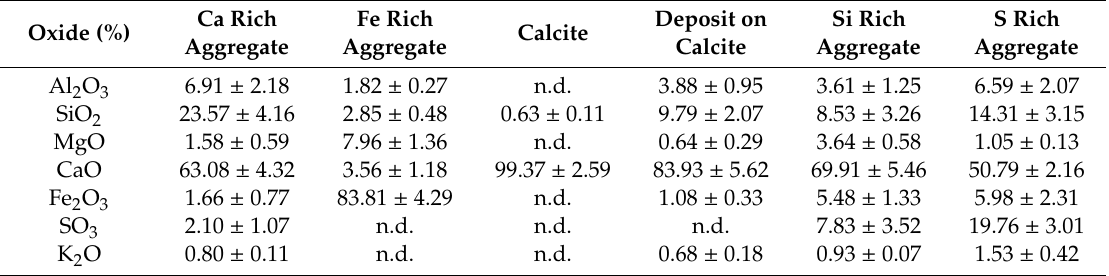
Table 3. Energy dispersive X-ray spectroscopy (EDX) chemical analysis of limestone waste.